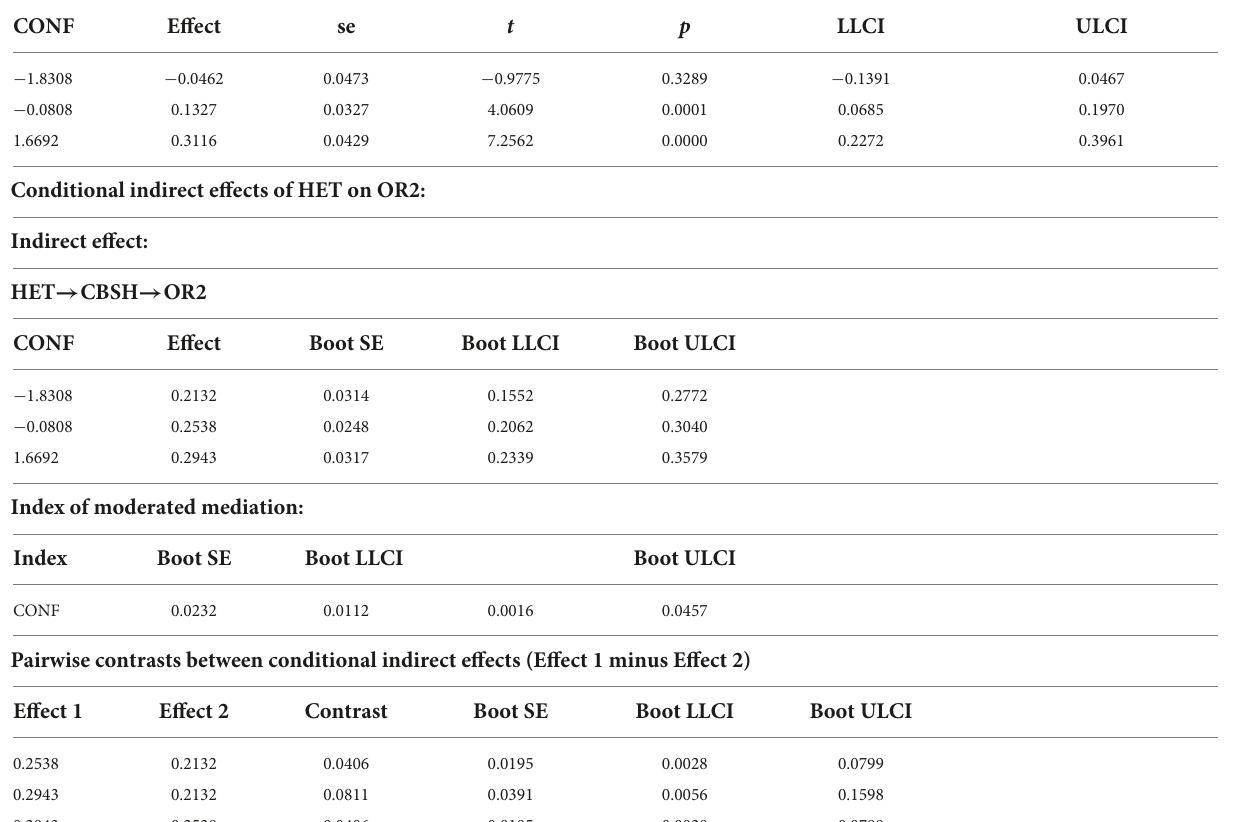
TABLE 6 Direct and indirect effects of the OR2 and index of moderated mediation.